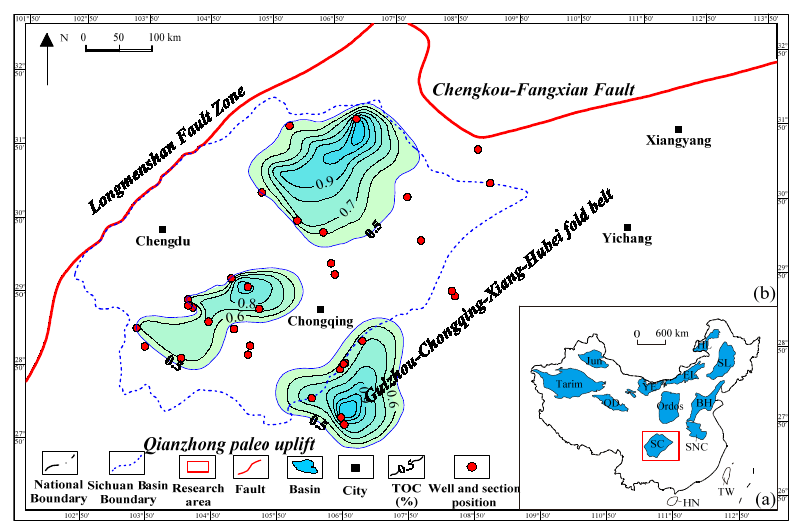
Figure 1. ( a ) Petroliferous basins of China and position of the Sichuan Basin and its adjacent areas; ( b ) Structural division and TOC of the Sichuan Basin and its adjacent areas. TOC = Total organic carbon; Jun = Junnggar Basin; YE = Yingen-Ejinaqi Basin; EL = Erlian Basin; HL = Hailaer Basin; SL = Songliao Basin; QD = Qaidam Basin; BH = Bohai Bay Basin; SC = Sichuan Basin